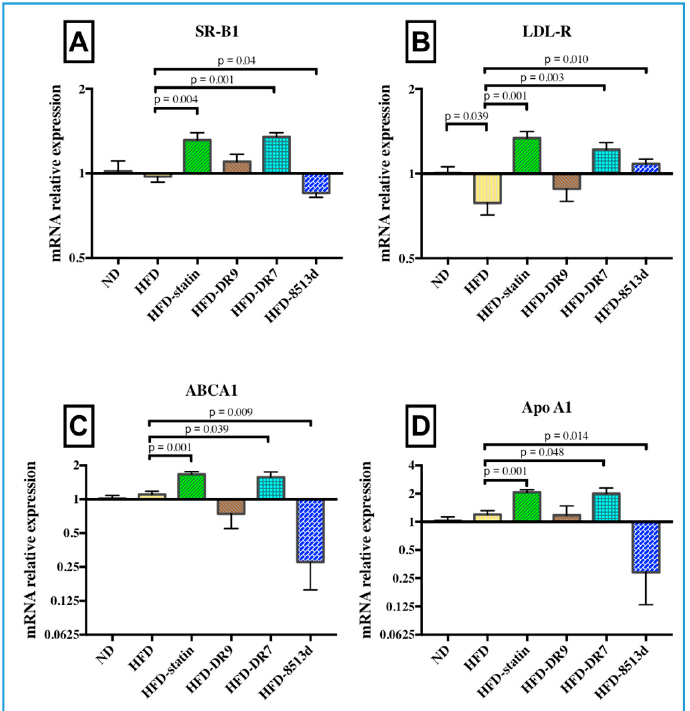
Figure 7. Relative gene expression of ( A ) SR-B1 , ( B ) LDL-R , ( C ) ABCA1 , and ( D ) Apo A1 in liver of D-galactose-induced aging rats (600 mg/kg/day) after 12 weeks of treatment. ND (normal diet), HFD (high-fat diet), HFD-statin (high-fat diet, receiving lovastatin 2 mg/kg/day), HFD-DR9 (high-fat diet, receiving L. fermentum DR9 (10 10 CFU/day), HFD-DR7 (high-fat diet, receiving L. plantarum DR7 (10 10 CFU/day), HFD-8513d (high-fat diet, receiving L. reuteri 8513d (10 10 CFU/day). Results are expressed as mean; error bars (SEM); n = 6. Statistical analysis was performed using independent t -tests.